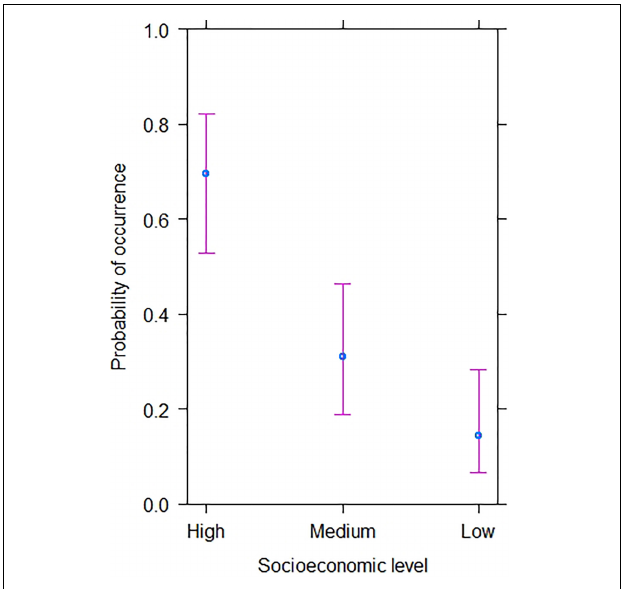
FIGURE 2 | Results from Generalized Linear Model predicting the occurrence of the Green-backed Firecrown hummingbird according to neighborhood socioeconomic level.